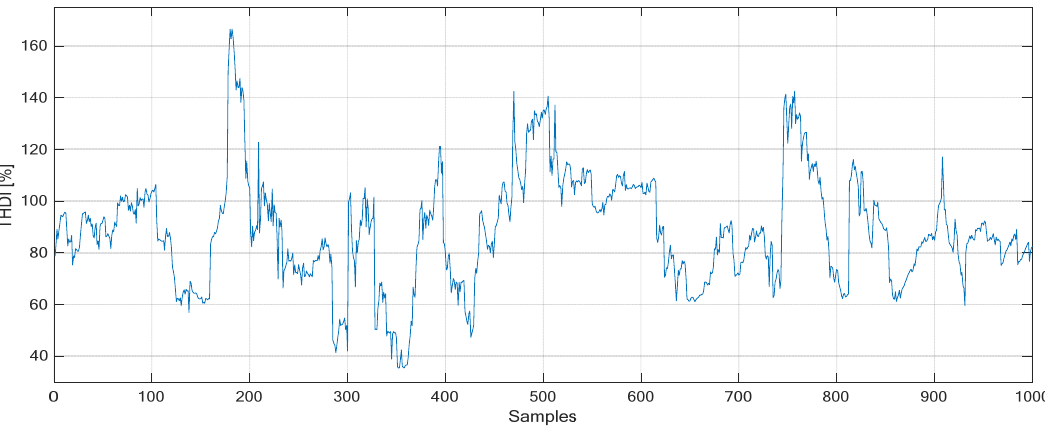
Figure 4. The variation in the THDI in the power supply station for approximately 16 min.